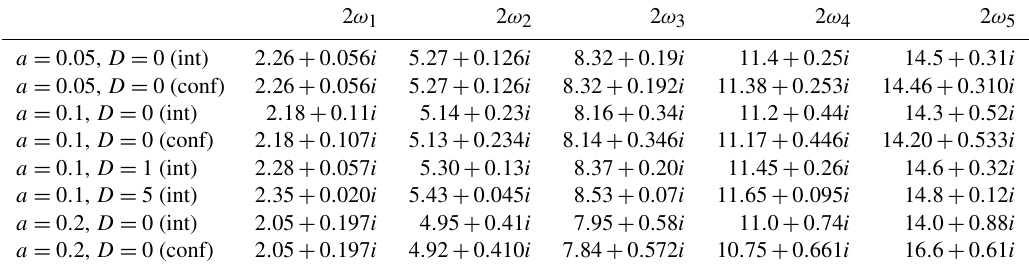
Table 2. The complex natural frequencies multiplied by 2 are tabulated for Model-2. These are essentially those 2 ω k that are the roots of 1 /A 0 (ω) . In this table those lines with “(int)” list the frequencies calculated using A 0 (ω) obtained from minimising the penalty integral (Eq. 45). The lines with “(conf)”, on the other hand, use Eq. (48) from the conformal mapping formulation for this quantity. Note that 2 ω k tend to the roots of J 0 for large D or small a